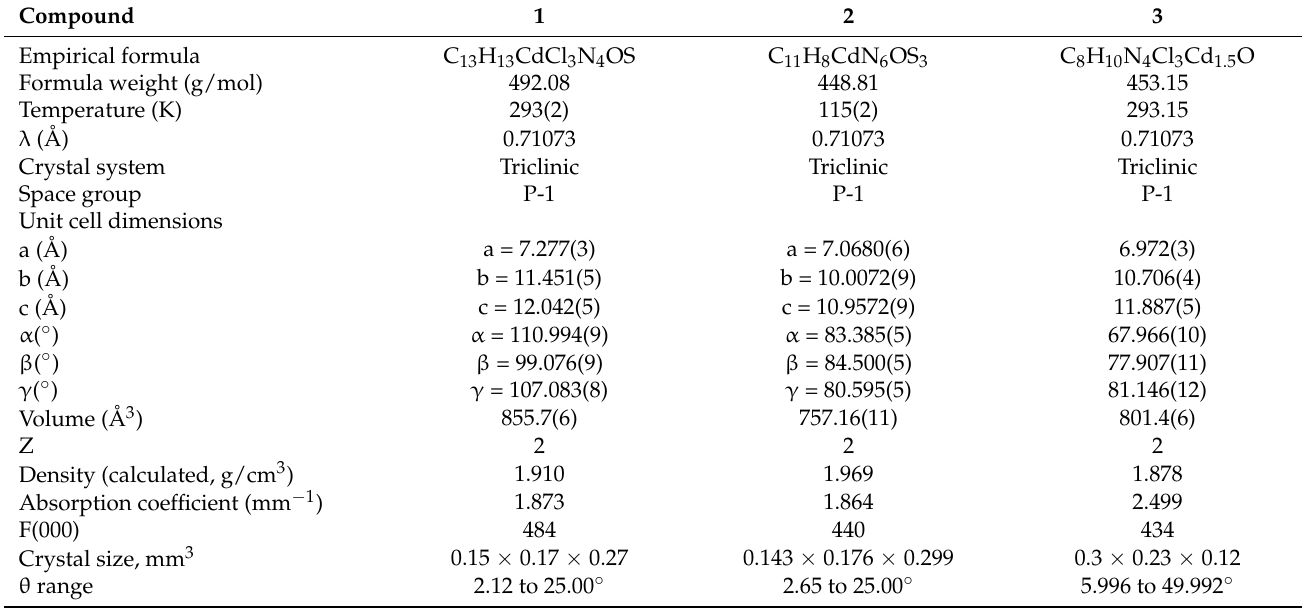
Table 1. Crystal data and refinement details of the studied complexes.